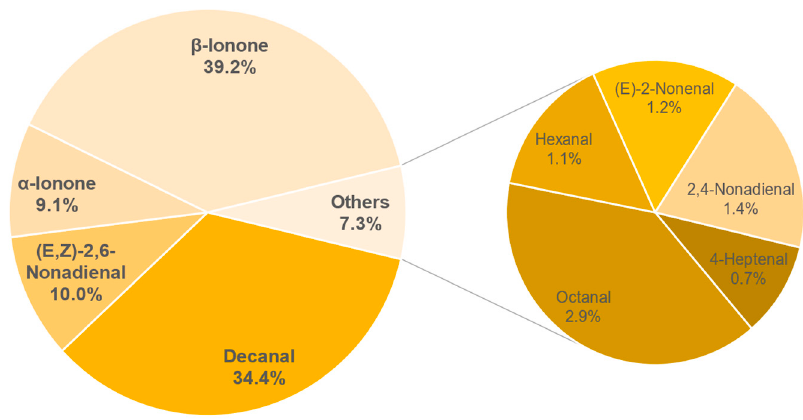
Figure 17. Percentage of OAV of each compound in the total aroma of sample 156.